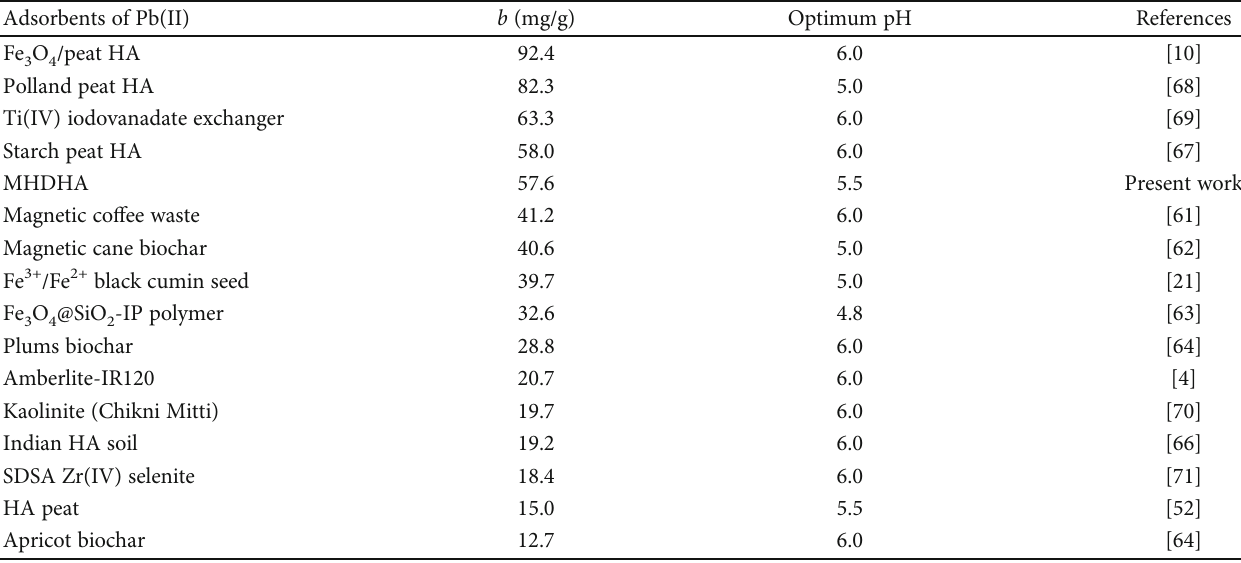
Table 4: Comparison of Langmuir sorption capacity ( b ) in Pb(II) adsorption by various functionalized magnetite, -HA, and other low-cost adsorbents at